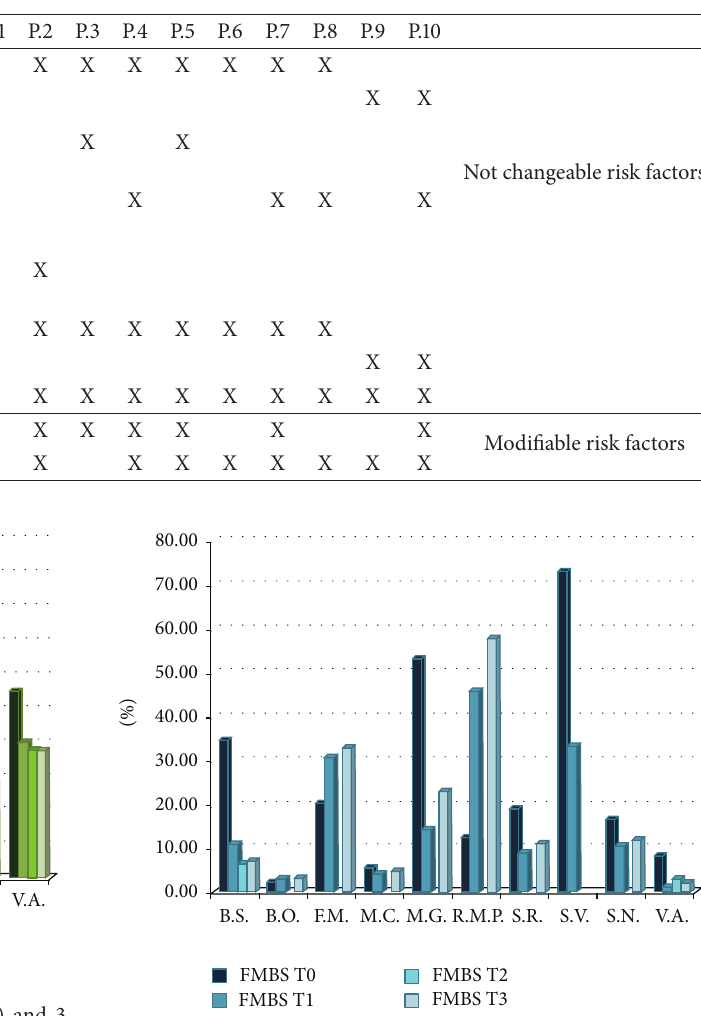
Figure 2: FMBS detected before the start of therapy (T0) and 3 months (T1), 6 months (T2), and 18 months (T3) after. The patient S.V. died before the follow-up at 18